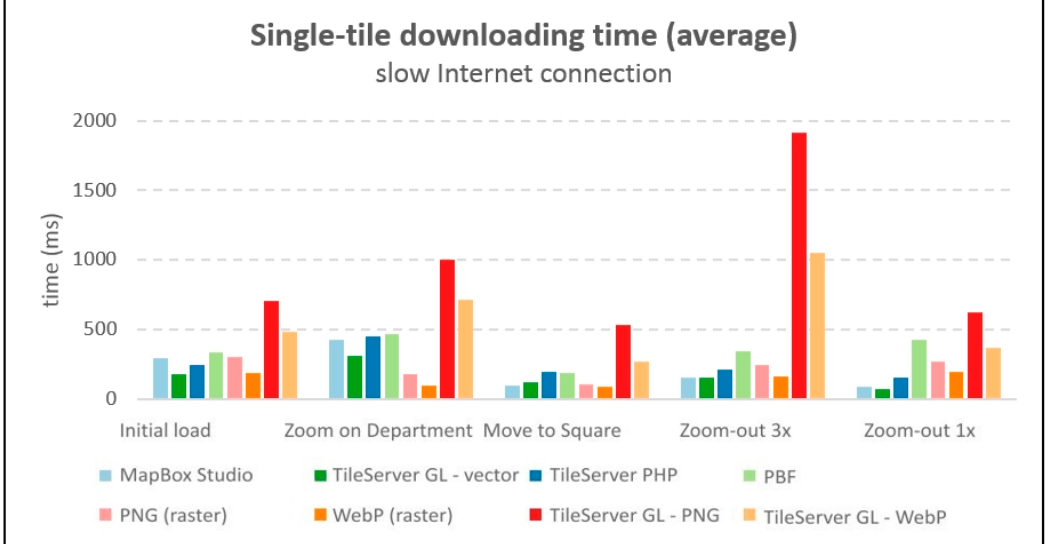
Figure 6. Results of single-tile downloading times (slow Internet connection).